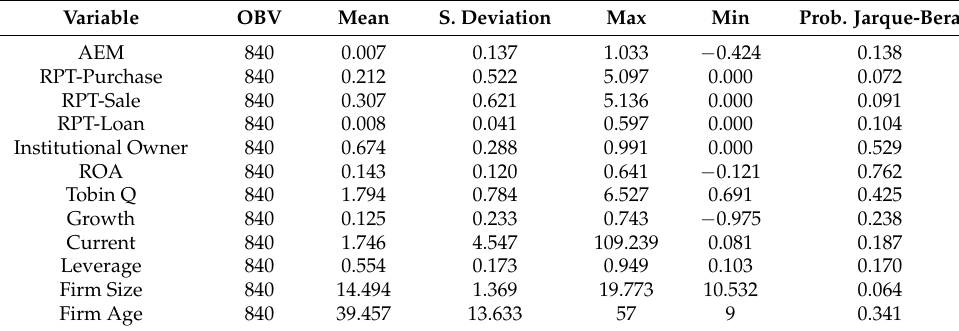
Table 3. Descriptive statistics of quantitative